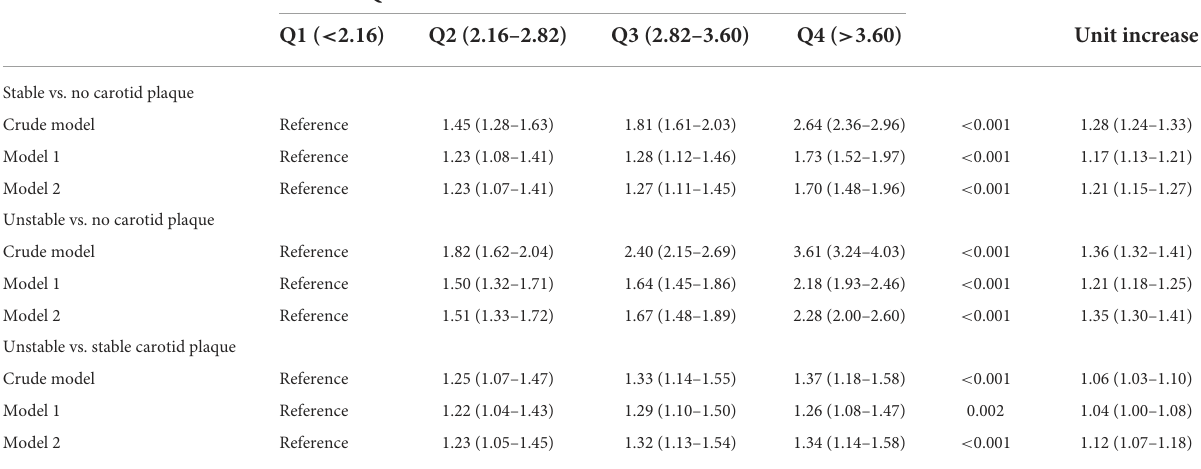
TABLE 3 Sensitivity analysis †